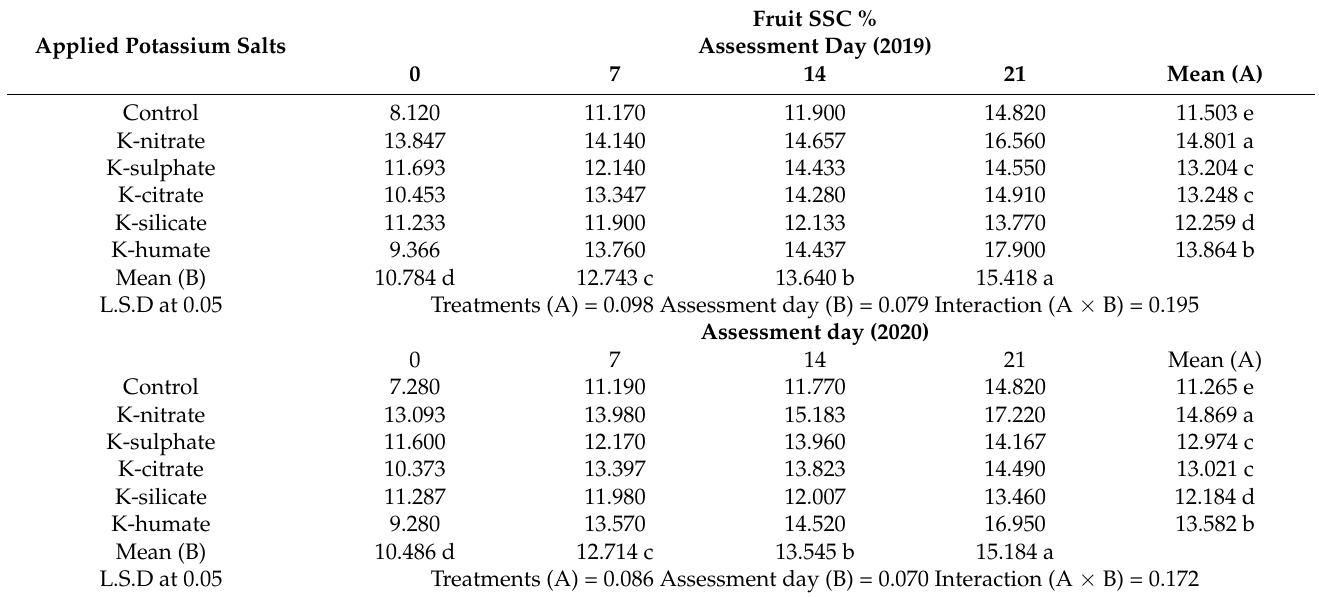
Table 6. Effect of diverse potassium sources as foliar application on SSC % of apricot fruits cv. ‘Canino’ in 2019 and 2020 seasons during cold storage 0 ± 1 ◦ C and 90 ± 5%